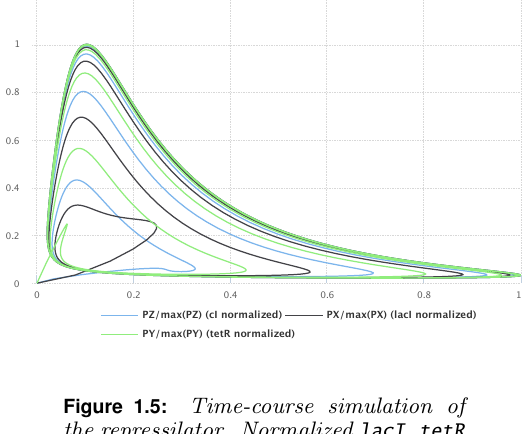
Figure 1.5: Time-course simulation of the repressilator. Normalized lacI , tetR and cI in phase-plane. Simulation with SED-ML web tools [2].